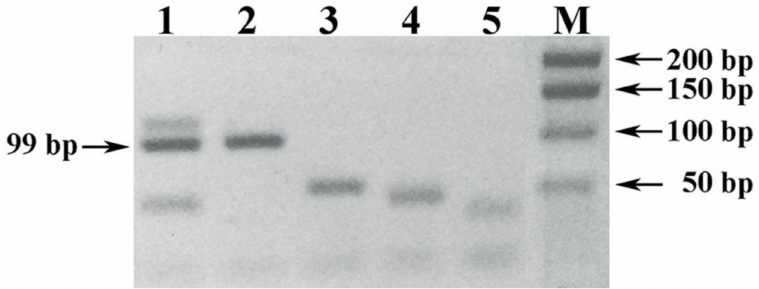
Figure 7. Electrophoregram of the result of PCR amplification of the Vitis vinifera L. UFGT gene locus with UFGT-F1 and UFGT-R1 primers for the negative effect of cold stabilization on the DNA under research. Legend: (1–2) PCR of a DNA sample extracted with “DNA-sorb-S-M kit” from the precipitated red wine debris Lagar De Robla (Mencia), sampled by a 10-min exposure in a mixture with PVP and isopropanol immediately after uncorking the bottle. (3–4) PCR of a DNA sample extracted with “DNA-sorb-S-M kit” from the precipitated red wine debris Lagar De Robla (Mencia), sampled by a 10-min exposure in a mixture with PVP and isopropanol on the next day after uncorking the bottle and storing it in the refrigerator. (M) DNA size markers 50+ bp (Evrogen JSC, Moscow,